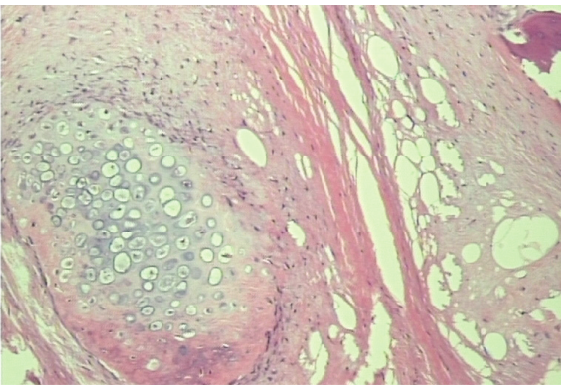
Figure 8: Area of cartilagenous